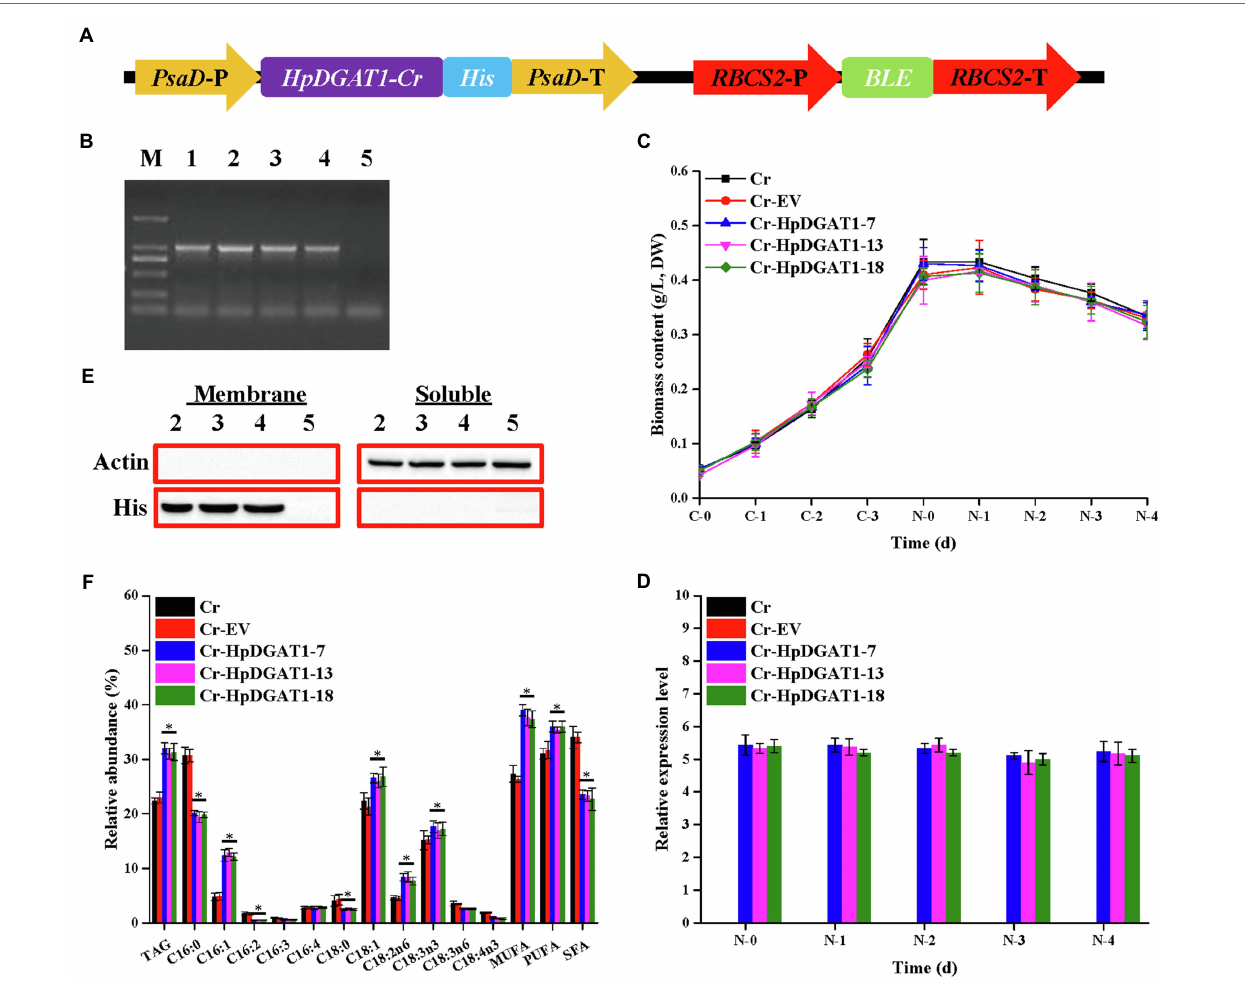
FIGURE 3 | Genetic engineering of HpDGAT 1 in Chlamydomonas reinhardtii cells. (A) Construct of the expression vector. PsaD -P, promoter of PsaD gene; His tag, 6-His encoding gene; PsaD -T, terminator of PsaD gene; RBCS2 -P, promoter of RBCS2 gene; Ble , the bleomycin -resistant gene; and RBCS2 -T, terminator of RBCS2 gene. (B) Genomic level of HpDGAT1 in C. reinhardtii cells. 1: pDB124- HpDGAT1 ; 2: Cr + HpDGAT1 -7; 3: Cr + HpDGAT1 -13; 4: Cr + HpDGAT1 -18; and 5: Cr + EV. (C) Time course of biomass content under control and ND conditions. (D) The transcriptional expression levels of HpDGAT1 in C. reinhardtii cells. The gene expression levels were normalized to the endogenous CrACTIN gene. (E) Western blotting. Soluble and membrane proteins were separated and used for blotting. 2: Cr + HpDGAT1 -7; 3: Cr + HpDGAT1 -13; 4: Cr + HpDGAT1 -18; and 5: Cr + EV. (F) TAG content and relative abundance of fatty acids in C. reinhardtii cells transformed with